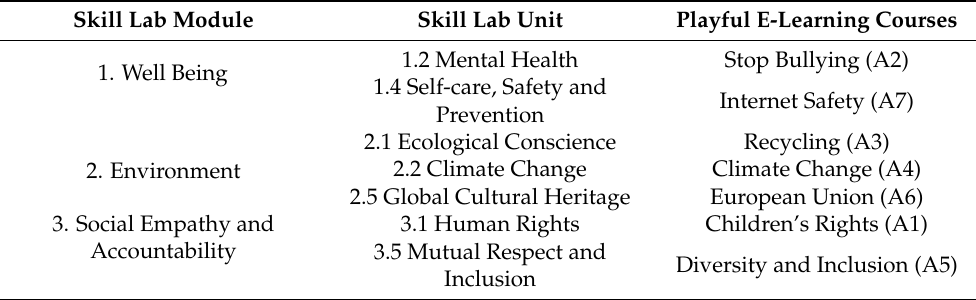
Table 6. E-learning modules alignment with 21st century Skills Labs in Greek